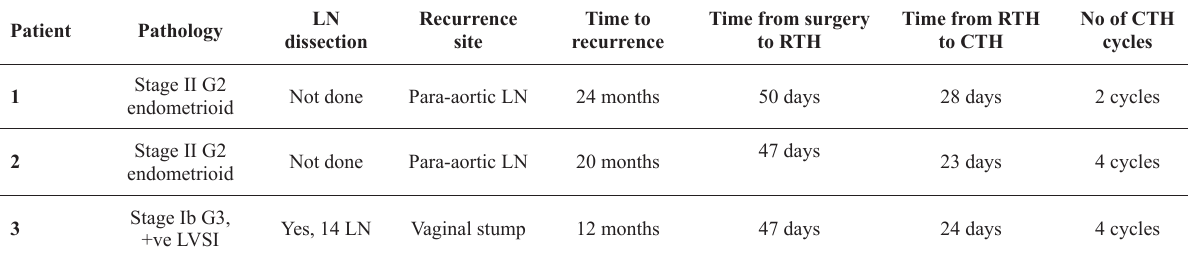
table 4: Details of three patients with disease recurrence